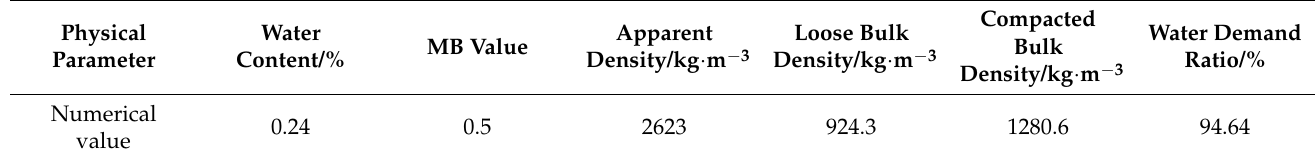
Table 4. Physical parameters of stone powder.